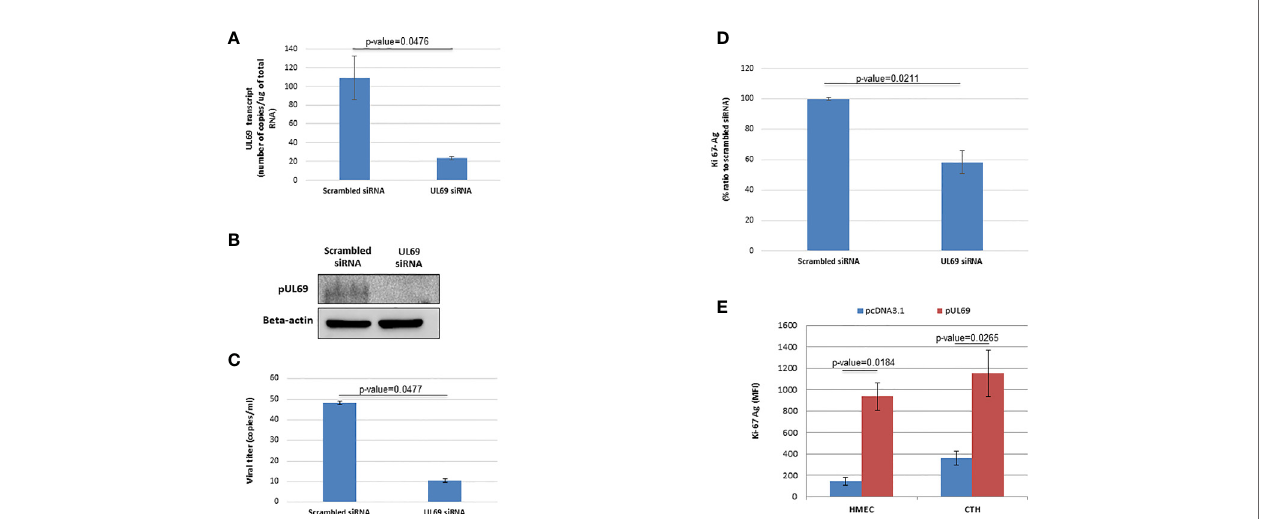
FIGURE 5 | pUL69 favors HCMV replication and cellular proliferation in CTH cells. (A, B) Knockdown of UL69 transcript and protein in CTH cells was monitored by RT-qPCR assay (A) and western blot (B) respectively. CTH cells were treated with UL69 siRNA and a scramble control. RT-qPCR assay and western blot were performed as speci fi ed in Methods. (C) Knockdown of UL69 resulted in decreased HCMV replication in CTH cell cultures as measured by detection of IE1 in culture supernatants by qPCR assay. (D) UL69 knockdown decreased CTH cell proliferation as measured by Ki67Ag quanti fi cation (MFI, mean fl uorescence intensity) by fl ow cytometry. (E) Overexpression of pUL69 favors the proliferation of HMECs and CTH cells. Increased cellular proliferation as measured by Ki67 antigen quanti fi cation (MFI) by fl ow cytometry in HMEC and CTH cells transfected with pUL69 plasmid. Empty pcDNA3.1 transfected cells were used as control. Results are means (± SD) of three independent